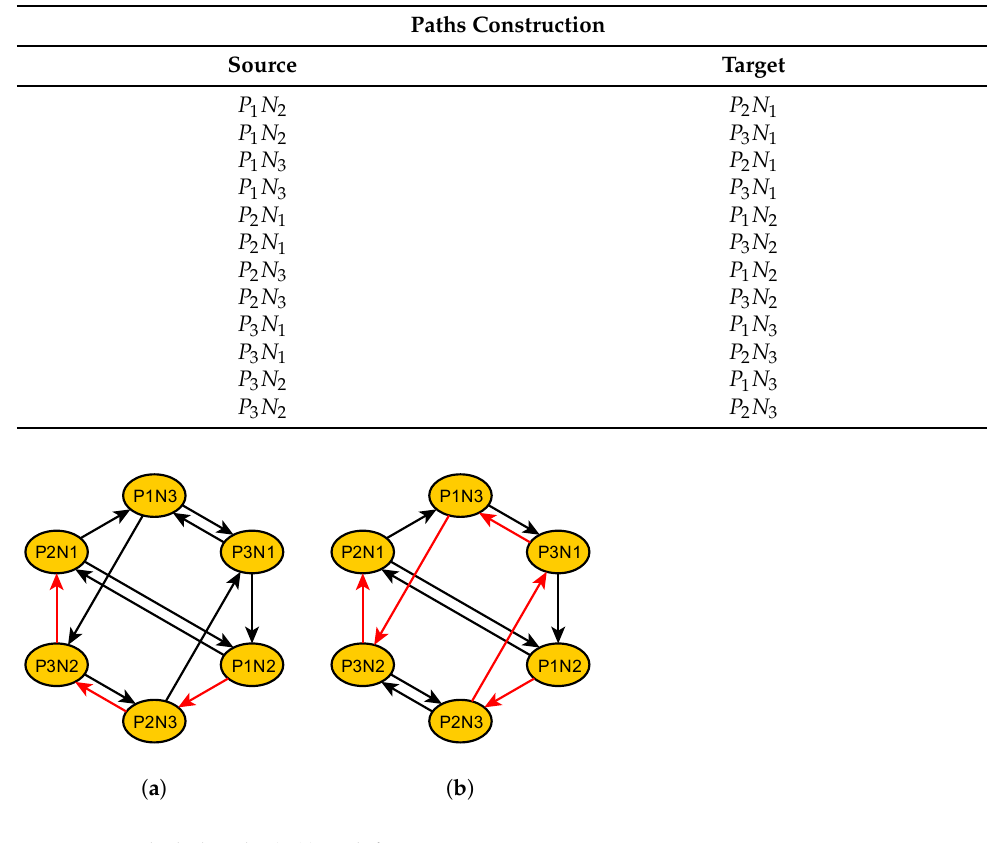
Figure 6. Excluded paths ( a , b ) to define capacitors’